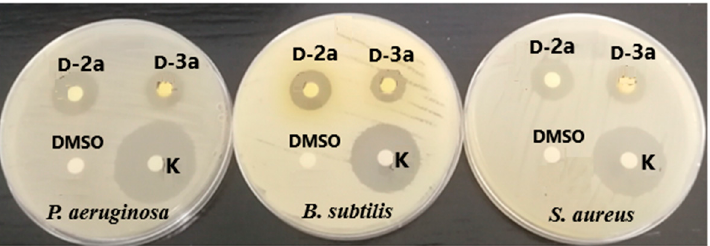
Figure 9. Inhibition zone of D - 2a and D - 3a against P. aeruginosa , B. subtilis, and S. aureus ( D - 2a , D - 3a —1 mg/disk; K—Kanamycin 50 µ g disk—positive control, DMSO—negative control). Table 2. Growth inhibition zones of the tested microorganisms and minimum inhibitory concentra- tions (MIC) of the tested compounds D - 1a , D - 2a, and D - 3a . Compound Test Microorganisms